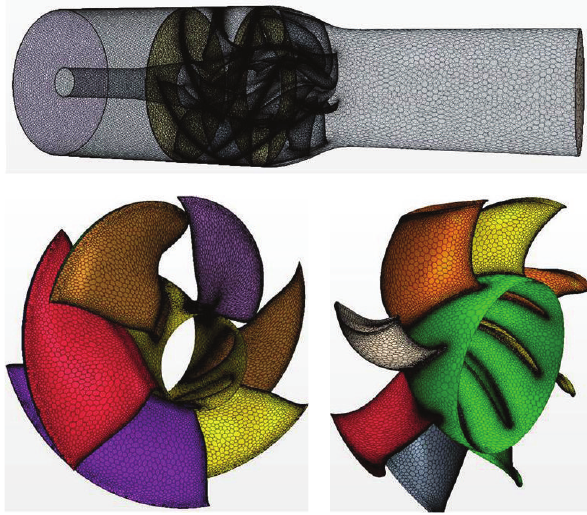
Figure 1: Mesh and geometry of the AxWJ-2 waterjet.